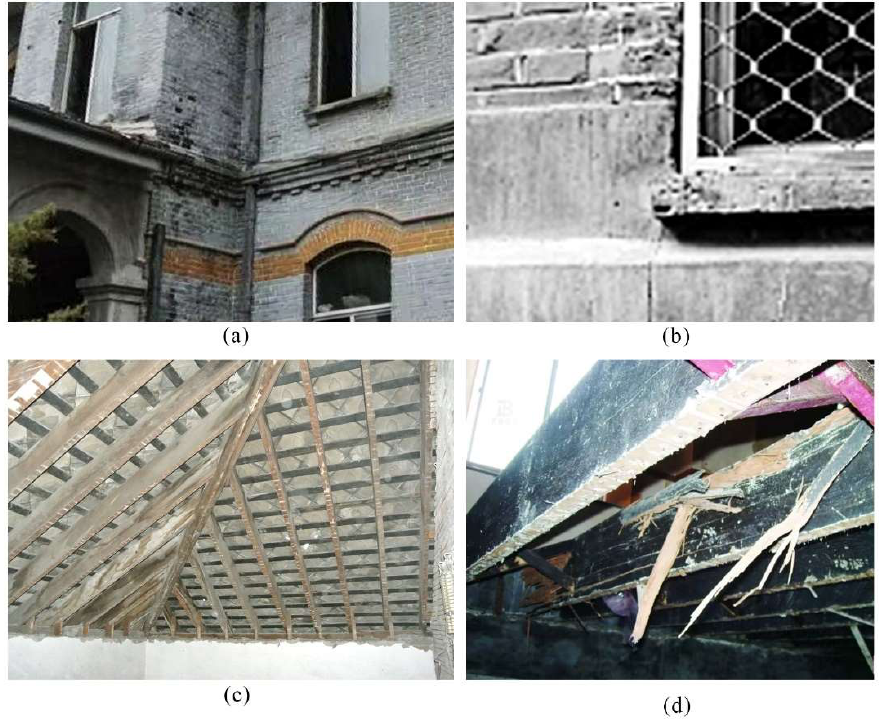
Figure 15. Damaged state (source: author). ( a ) Damaged exterior walls ( b ) Cracked window corner ( c ) Rotted wood roof trusses ( d ) Cracked wood joists.